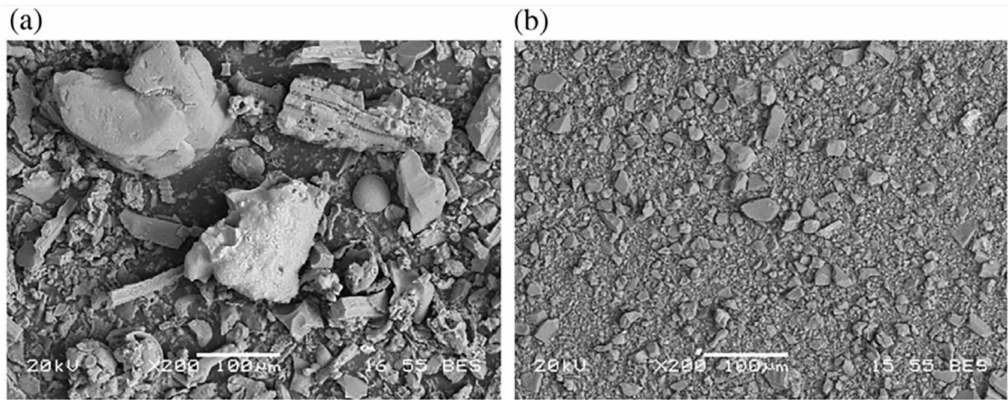
Figure 8. Micromorphology of SCBA produced after 8 min ( a ) and 240 min ( b ) grinding